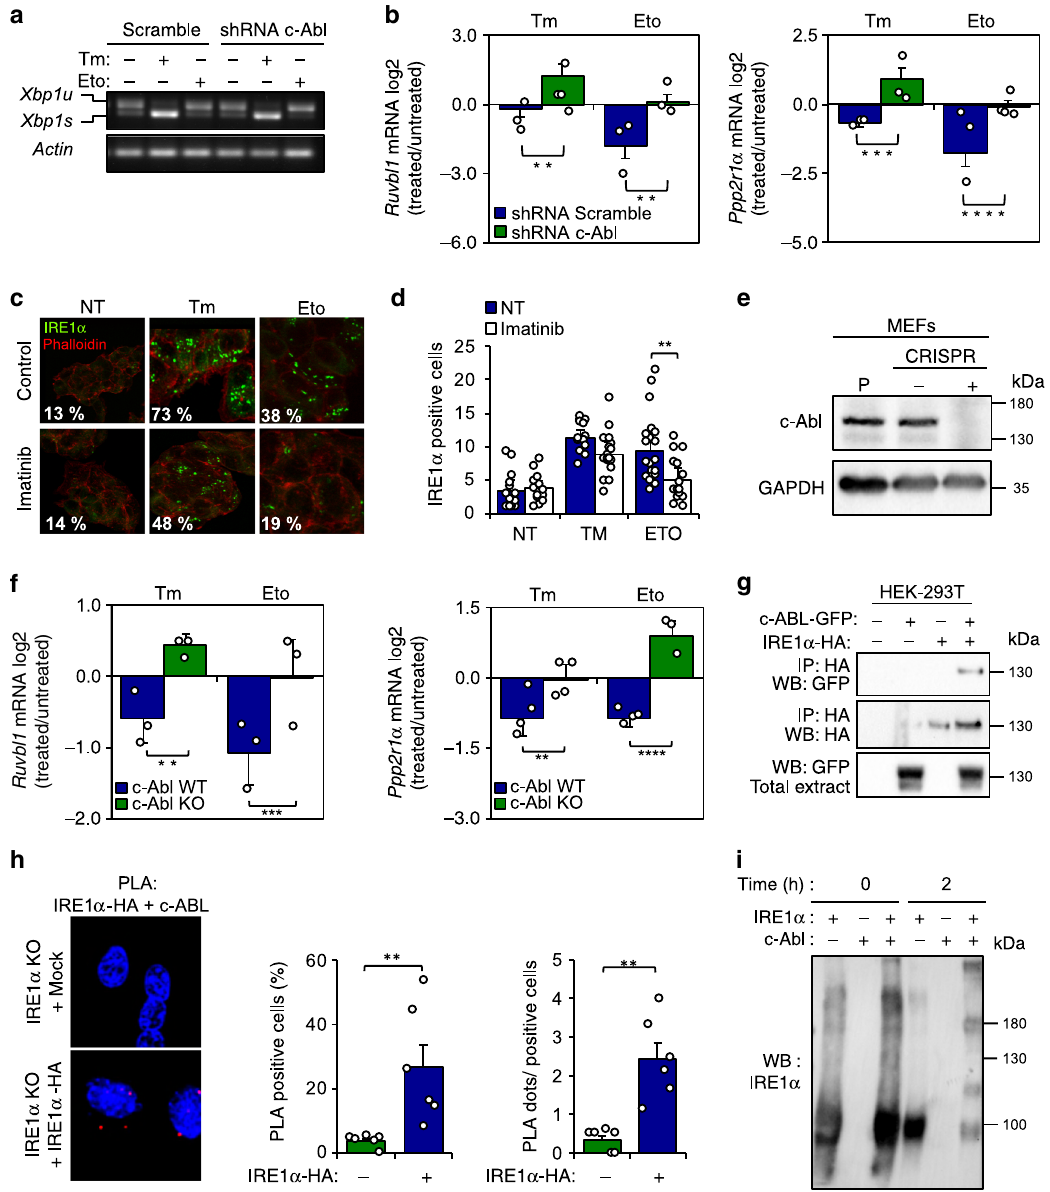
Fig. 4 c-Abl contributes to the RIDD activation under DNA damage. a c-Abl was knocked down through the stable delivery of an shRNA. Then cells were treated with 10 μ M Etoposide (Eto) or 500 ng/mL tunicamicyn (Tm) for 8 h and Xbp1 mRNA splicing was monitored by RT – PCR ( n = 3). b MEF ShRNA Scramble and ShRNA c-Abl cells were treated with 10 μ M Eto or 500 ng/mL Tm for 8 h, and the decay of Ppp2r1a and Ruvbl1 was measured by real-time- PCR ( n = 3). c Trex-IRE1-GFP cells were pre-treated with 10 μ M imatinib by 1 h, and then treated with 10 μ M Eto, or 500 ng/mL Tm for 8 h and IRE1-GFP foci visualized by confocal microscopy. d Quanti fi cation of the percentage of cells positive IRE1-GFP clusters is shown (>200 cells, n = 3). e c-Abl expression in CRISPR control and c-Abl KO cells was monitored by western blot ( n = 3). f CRISPR control and c-Abl KO cells were treated with 10 μ M Eto or 500 ng/mL Tm for 8 h, and the decay of Ruvbl1 and Ppp2r1a was measured by Real-Time-PCR ( n = 3). g HEK-293T cells reconstituted with IRE1 α -HA and c-Abl-GFP were exposed to 10 μ M Eto for 8 h. Immunoprecipitation (IP) was performed using the HA epitope (IRE1 α ) and GFP (c-Abl) to assess the possible interaction with c-Abl. h IRE1 α KO (Mock) and reconstituted cells with an IRE1 α -HA were treated 8 h with 10 μ M Eto and stained with a proximity ligation assay (PLA) using an anti-HA or anti-c-Abl antibodies and analyzed by confocal microscopy. Right panel: Number of dots per cell analyzed and percentage of PLA positive cells were quanti fi ed ( n = 6). i Recombinant IRE1 α and c-Abl proteins were incubated at indicated time points and assess its possible interaction by western blot. All data represents the mean ± s.e.m. of three independent experiments, except for co-IP that were performed twice. * p < 0.05, ** p < 0.01, and *** p < 0.001, based on ( b , f ) two-way ANOVA followed Bonferroni ’ s test, ( d , h ) One-way ANOVA followed Tukey ’ s test. Data is provided as a Source Data fi of tunicamycin, which elicits a rapid stress response in the liver. splicing was detected in the etoposide treated group (Fig. 6a, Although evident signs of DNA damage were observed in both bottom panel). In sharp contrast, a clear down-regulation of control and IRE1 α cKO animals (indicated by a rise in p21 mRNA) Ppp2r1a and Bloc1s1 mRNA levels occurred in the livers (Fig. 6b) (Fig. 6a upper panel and Supplementary Fig. 7a), no Xbp1 mRNA and bone marrows (Supplementary Fig. 7b) from control (but not